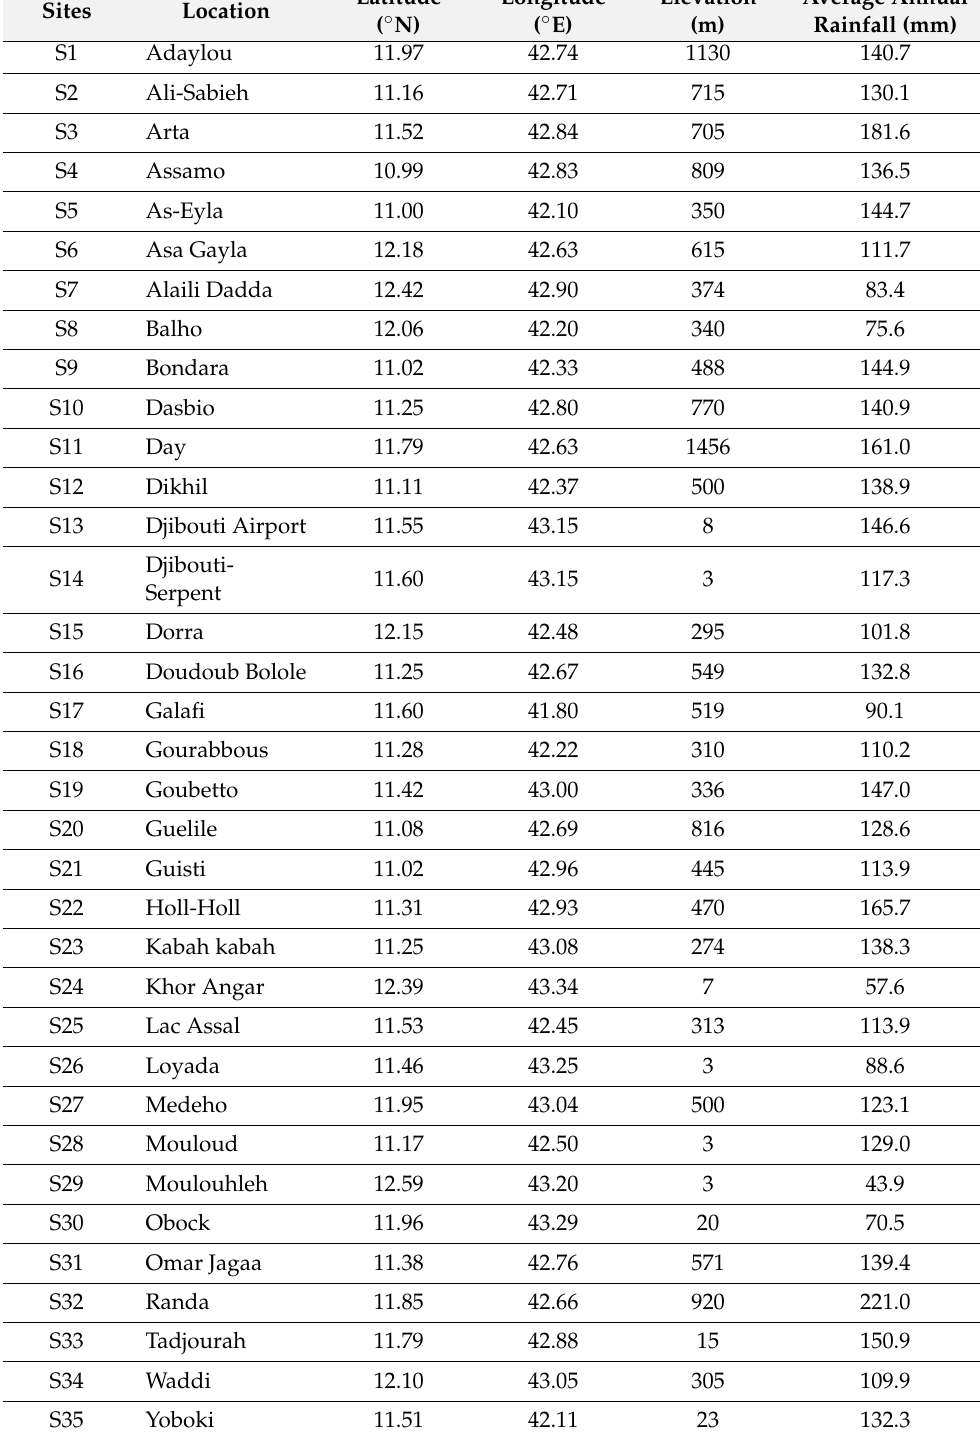
Table 1. Meteorological gauge station characteristics. All stations have data within the periods 1961–1991 and 2013–2021, with the exception of Djibouti Airport, which has complete data for